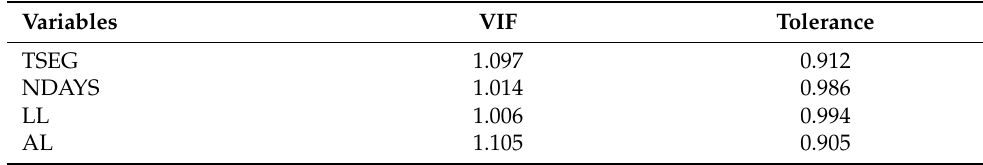
Table 5. VIF and tolerance evaluation of the predictors.